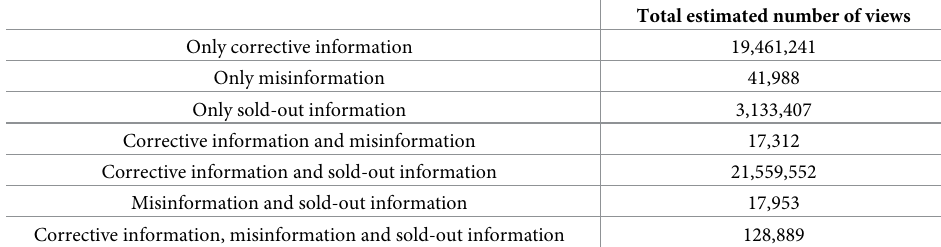
Table 2. Total estimated number of views of each type.